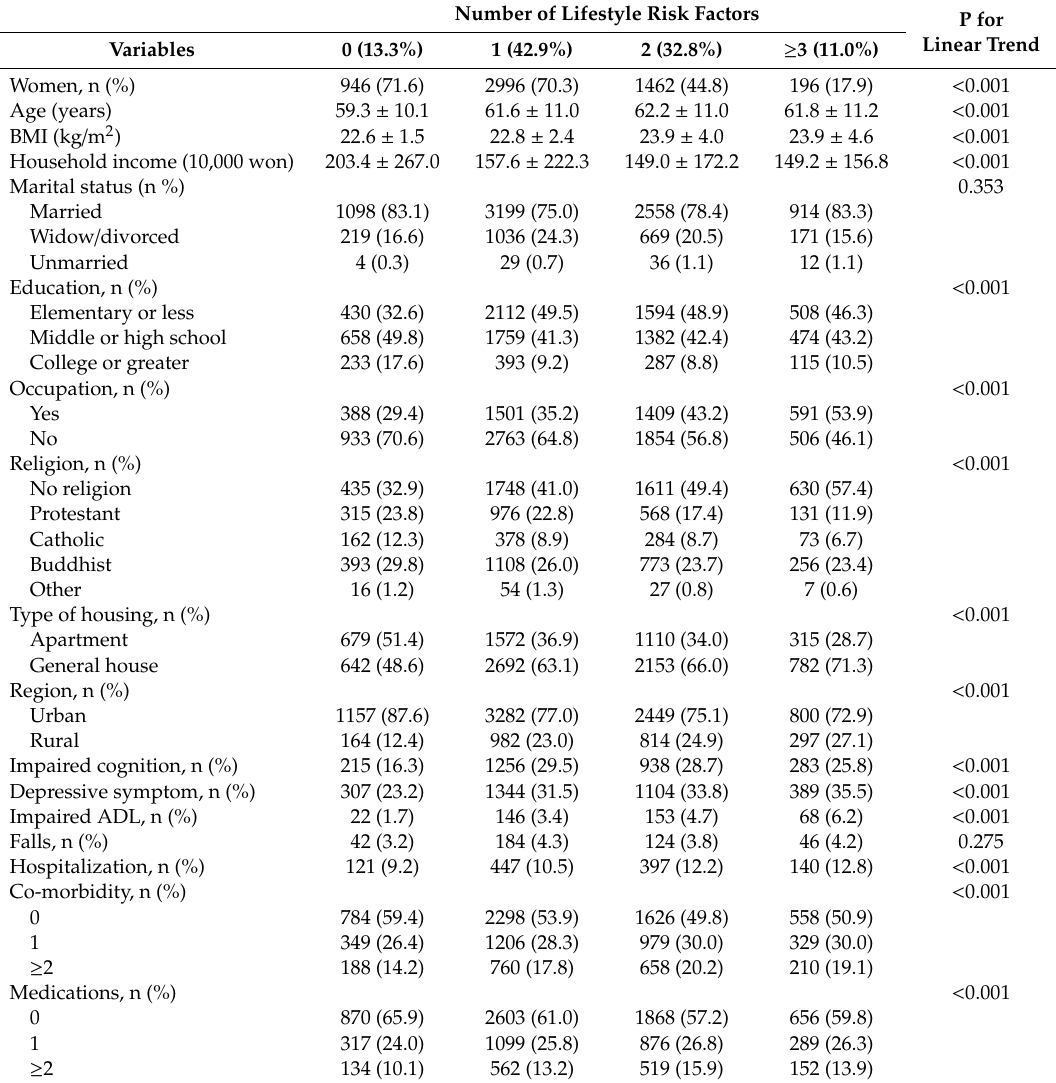
BMI: body mass index, ADL: activities of daily